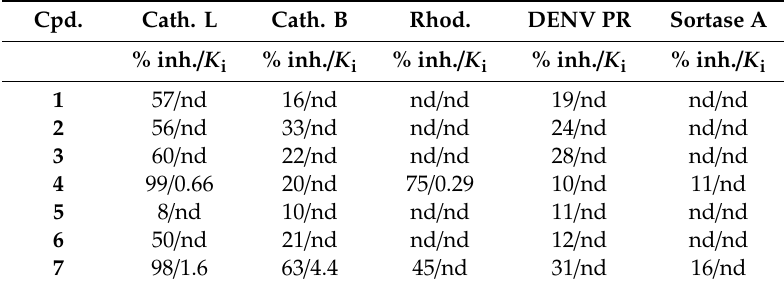
Table 1. Inhibition data for inhibitors of the general structure R-NH- l -Phe- l -Leu-OBn, % inhibition at 20 µ M and K i [ µ M] 1 .